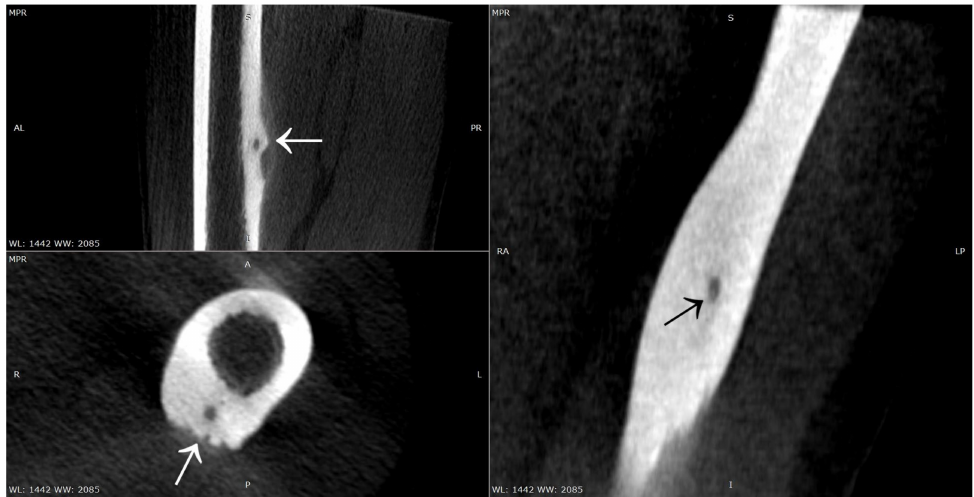
Figure 16. Intraoperative photographs during thermoablation with 3D navigation, showing nidus of OO (arrows) in the femur